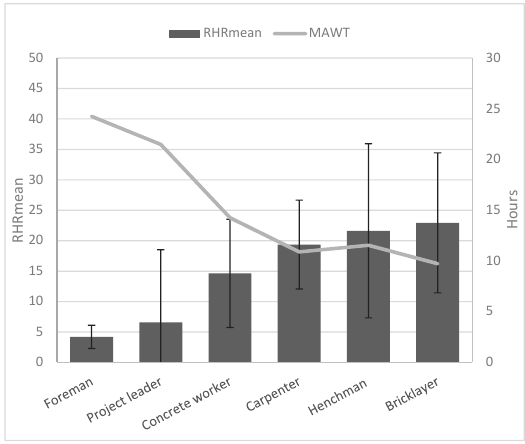
Figure 3. Mean relative heart rate during work and maximal acceptable worktime for professions.